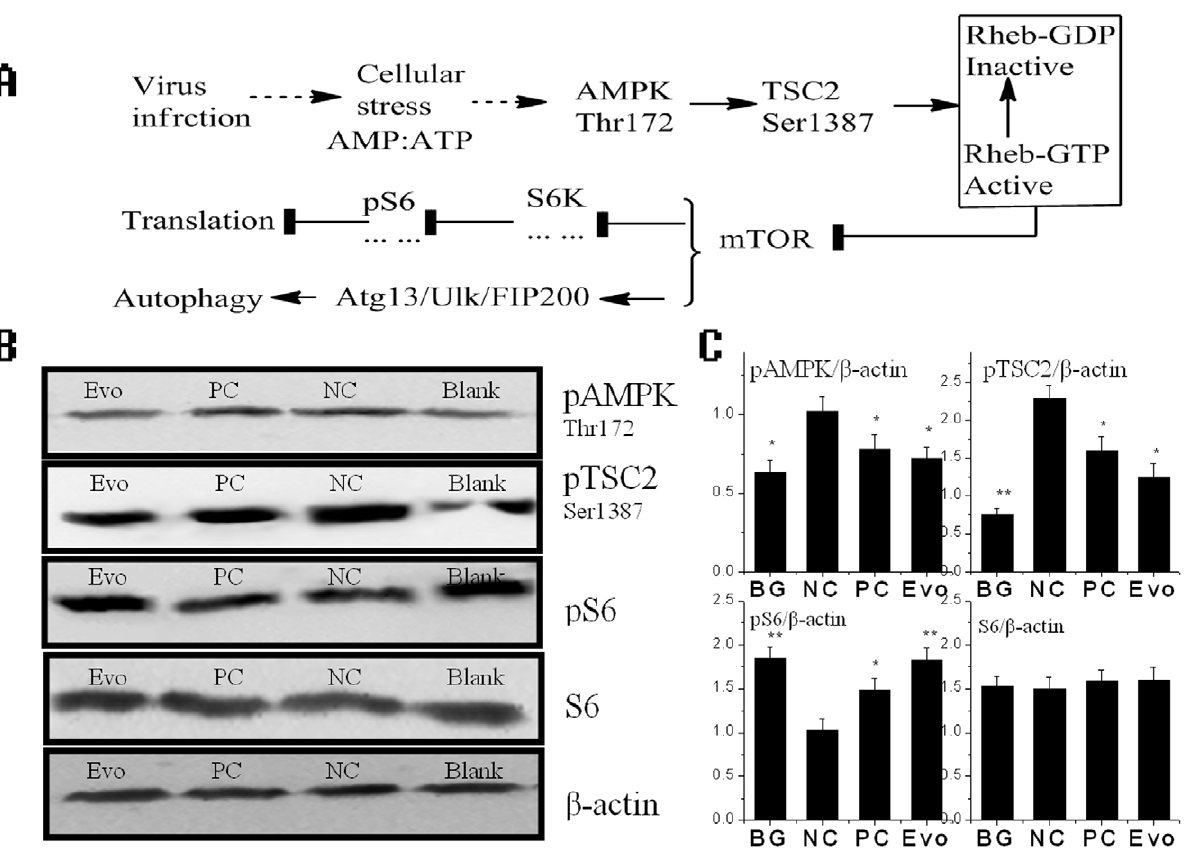
Figure 8. Evodiamine influences the AMPK/TSC2/mTOR pathway after IAV infection. ( A ) The speculated cellular response to viral infection mediated by AMPK/TSC2/mTOR pathway. ( B, C ) The influence of evodiamine on the AMPK/TSC2/mTOR signal pathway determined by Western blot assay. The treatments were same with that mentioned in Fig. 7. The data shown were the ratios of the expression of the target gene to b -action. Data shown were the mean 6 SD of three independent experiments. * P , 0.05, ** P , 0.01, vs . the NC.